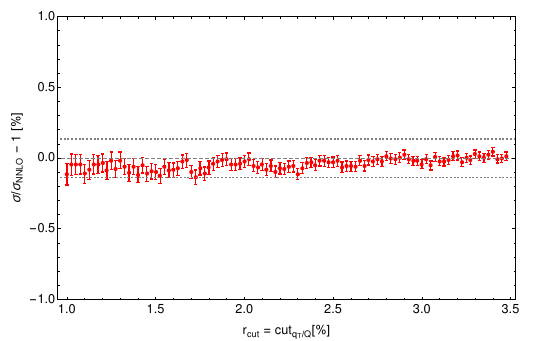
Figure 1 . Dependence of the total NNLO FTapprox cross section at 14 TeV on the q T -subtraction cut, r cut , normalized with respect to the extrapolated r cut ! 0 result. The dotted lines indicate the symmetrized uncertainty coming from the